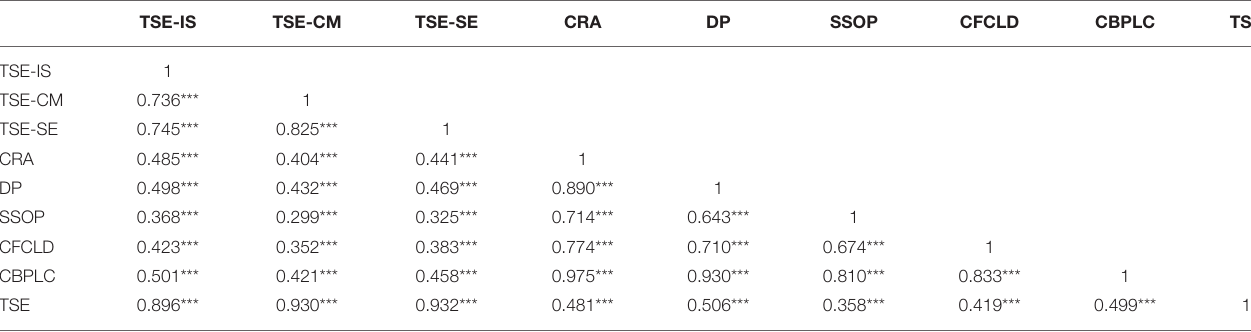
TABLE 4 | Correlation coefficients of CBPLC with teacher self-efficacy ( N = 1,413). TSE-IS